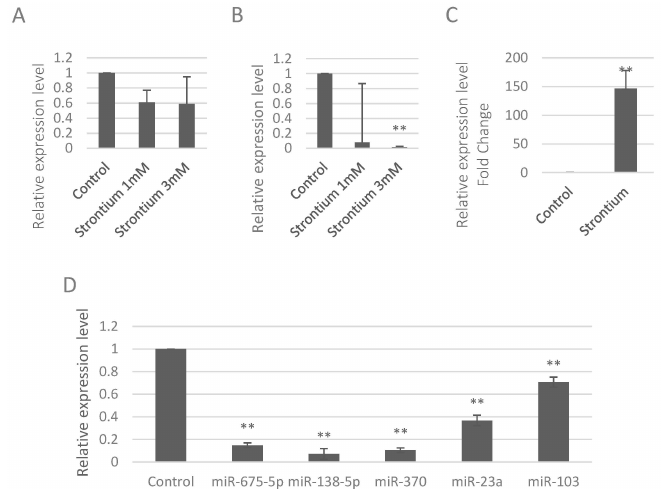
Figure 1. Strontium altered the expression levels of miRNA in vitro and in vivo . ( A ) Expression levels of miR-9-5p in MC3T3-E1 cells upon strontium ranelate treatment; ( B ) Expression levels of miR142-3p in MC3T3-E1 cells upon strontium ranelate treatment; ( C ) Expression levels of ALP in the bone of the mice upon strontium treatment; ( D ) Expression levels of miRNAs in the bone of mice upon strontium treatment. ** p <